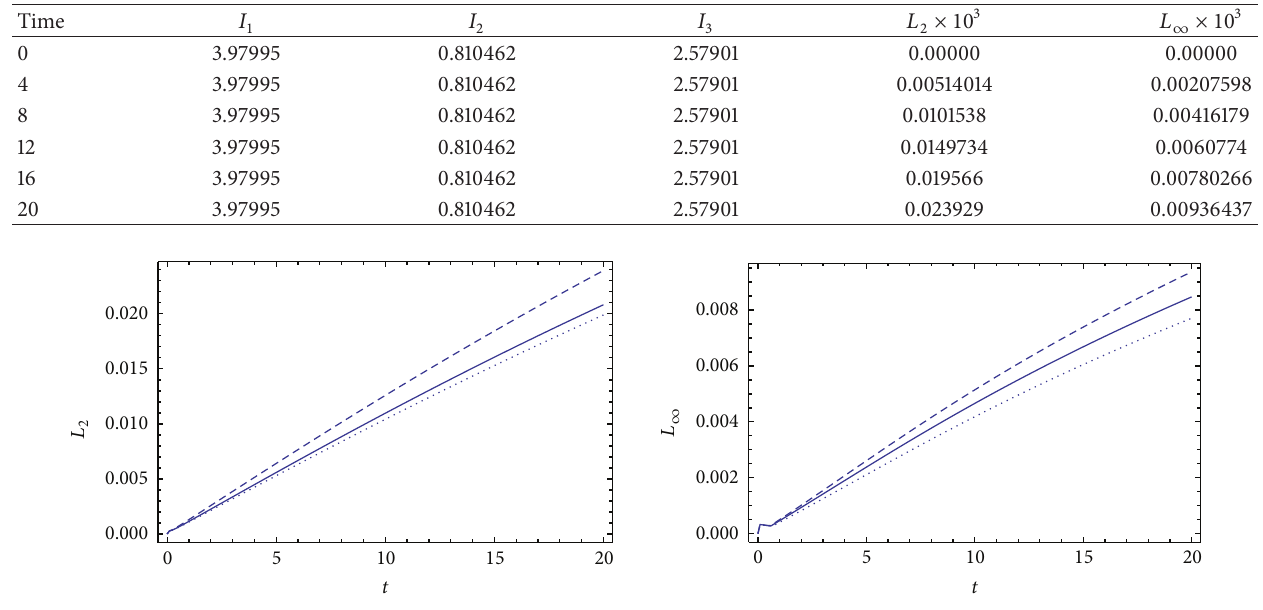
Figure 4: Plot showing the time evolution of the 𝐿 2 and 𝐿 ∞ norms for the implicit scheme (35) (solid line), the nonstandard numerical schemes (40) (− − −) and (43) (⋅⋅⋅)